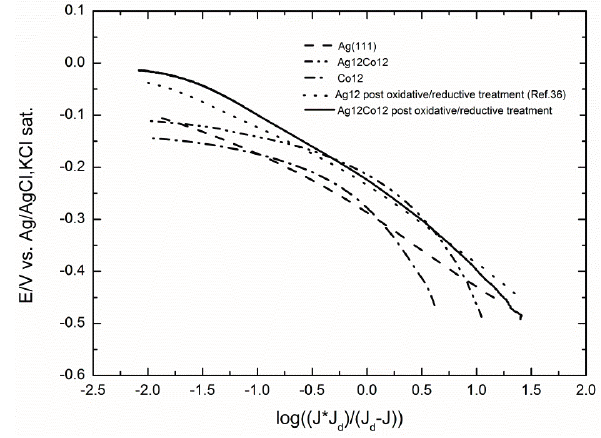
Figure 11. The Tafel plots for the ORR of the GC/Co, GC/Ag12Co12 before and after the oxidative/reductive treatment are compared to the Tafel plot of GC/Ag12 sample reported in [31] and the Tafel plot of a Ag(111)